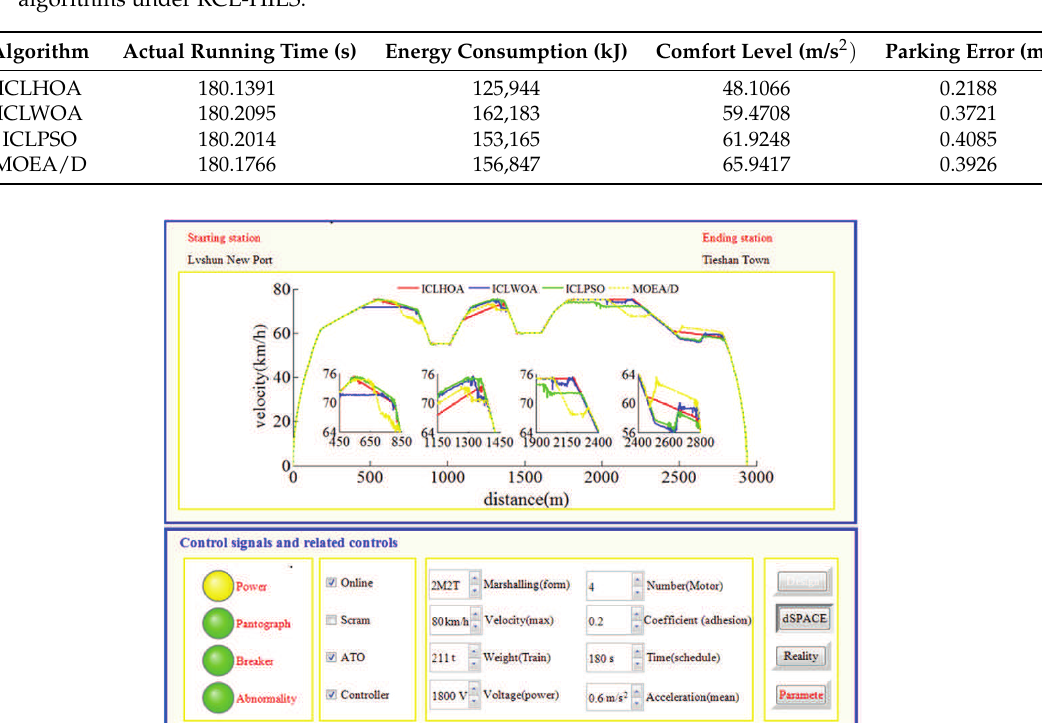
Figure 26. The actual velocity model predictive control (MPC) tracking trajectory profile obtained by different algorithms in